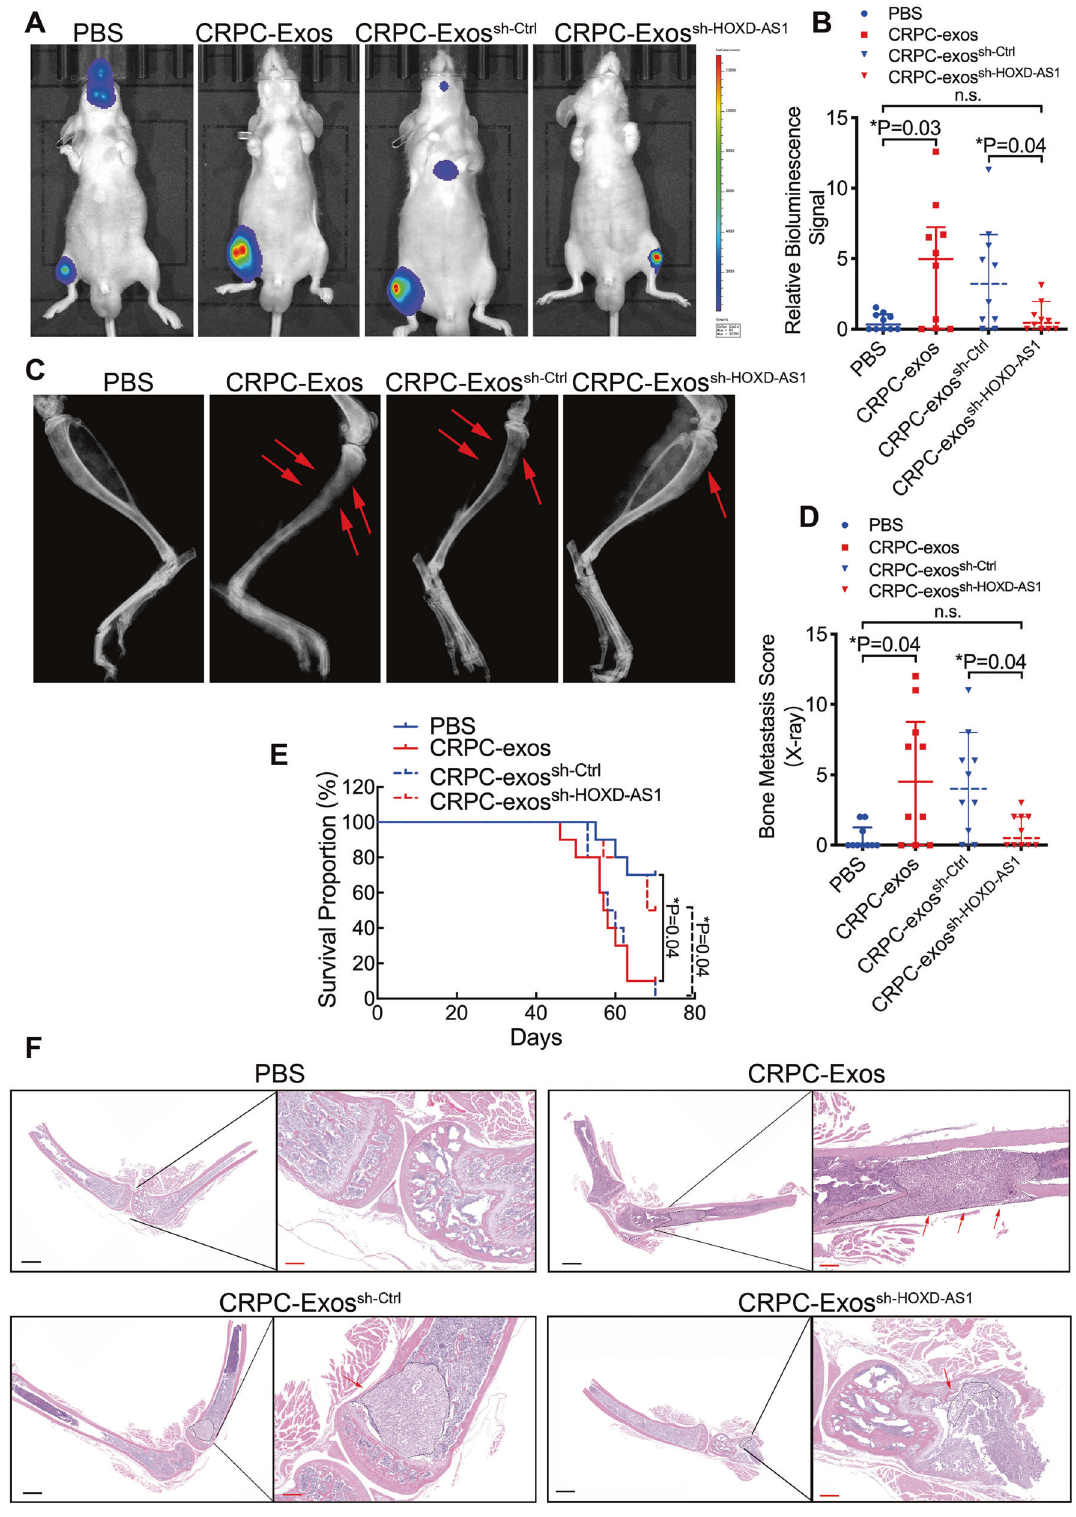
Fig. 4 Exosomal HOXD-AS1 promotes distant metastasis of PCa in vivo. A PC-3 cells were pre-treated with either PBS or CRPC-Exos, HOXD- AS1 knockdown CRPC-Exos or respective control for 48h and injected intra-cardiac to mimic the process of bone metastasis. Representative bioluminescence images of bone metastasis of a mouse at 8 weeks were displayed. B Quanti fi cation of the bioluminescence imaging signal in the PBS and CRPC-Exos groups, or HOXD-AS1 knockdown CRPC-Exos and its control at 8 weeks (each n = 10). The results are presented as medians ± interquartile. C Representative radiographic images of bone metastasis in the indicated mice (arrows indicate osteolytic lesions). D The sum of bone metastasis scores for each mouse in tumor-bearing mice in each group (each n = 10). The results are presented as medians± interquartile. E Kaplan – Meier analysis of bone metastasis-free survival in each group. F Representative images of H&E-stained sections of tibias from the indicated mouse. Arrows indicate the osteolytic lesions. Black dot-circled areas indicate the metastatic tumor in the bone. Black scale bars: 2000 μ m, red scale bars: 500 μ m. Exosomes were normalized by identical protein quantity. * p < 0.05, ** p < 0.01. See also Fig. S5. Cell Death and Disease (2021)